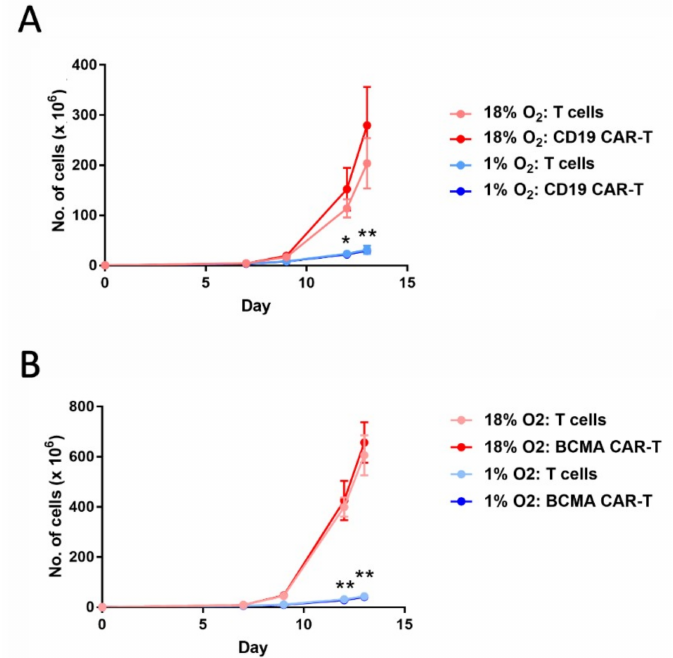
Figure 1. Hypoxia decreases chimeric antigen receptor-T cell (CAR-T cell) expansion. CD19 CAR-T cells ( A ) and B cell maturation antigen (BCMA) CAR-T cells ( B ), along with control T cells, were cultured in an 18% oxygen incubator for the entire 13-day expansion period (red lines), or were cultured in the 18% oxygen incubator for the first 5 days and then in a hypoxia chamber for the remaining 8 days (blue lines). Data-points represent the average and standard error of 4 separate experiments. * p = 0.02 (day 12) and ** p < 0.001 (day 13) for hypoxic vs. atmospheric CD19 CAR-T cells. ** p < 0.001 for hypoxic vs. atmospheric BCMA CAR-T